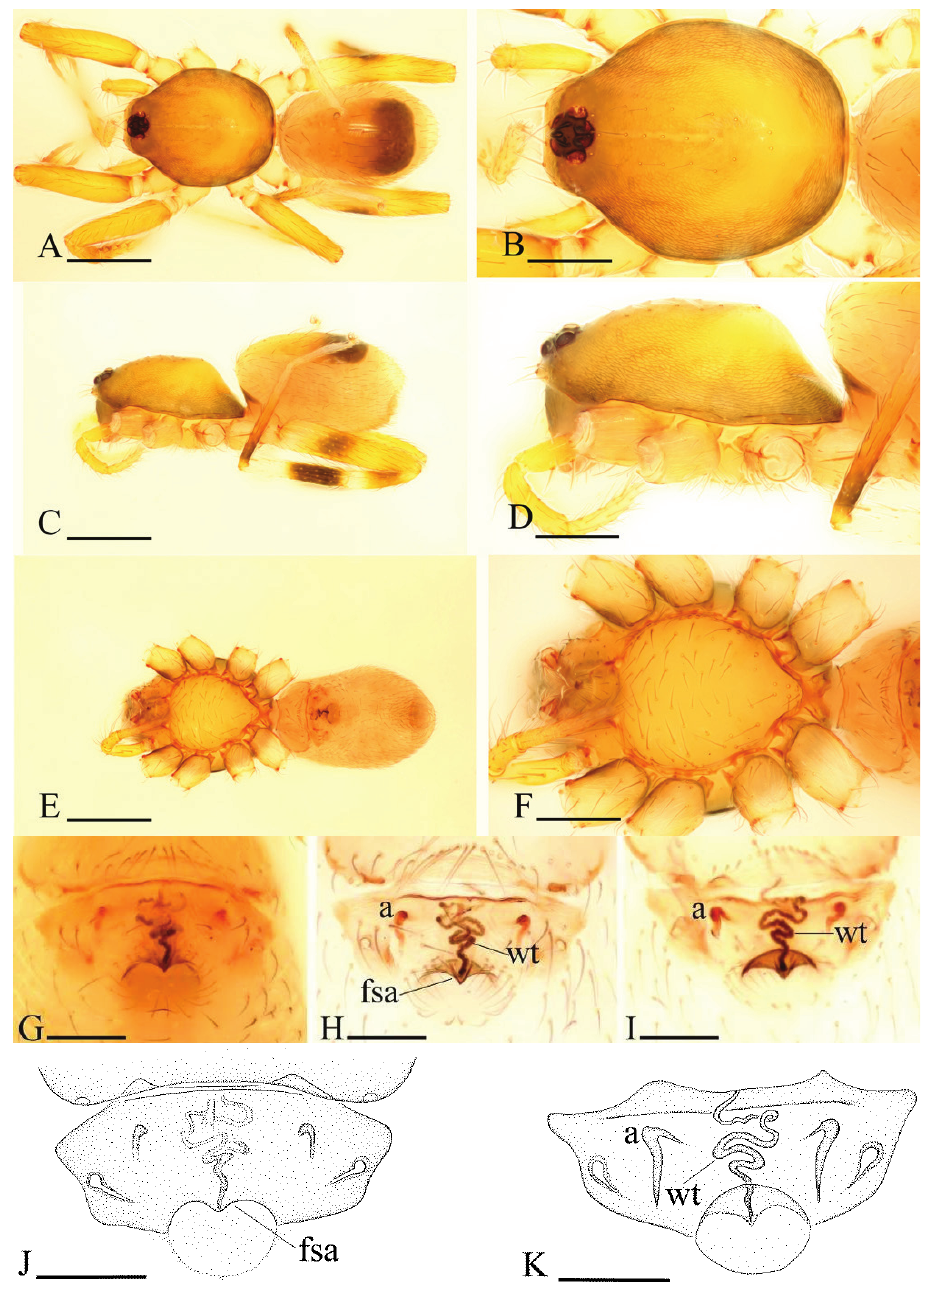
Figure 8. Ischnothyreus dactylinus sp. n., female. A, C, E habitus, dorsal, lateral and ventral views B, D, F prosoma, dorsal, lateral and ventral views G, H, J epigastric region, ventral view I, K epigastric region, dorsal view (H, I cleared in lactic acid). Abbreviations: a = apodeme; fsa = fan-shaped atrium; wt = winding tube. Scale bars: A, C, E = 0.4 mm; B, D, F = 0.2 mm; G–K = 0.1